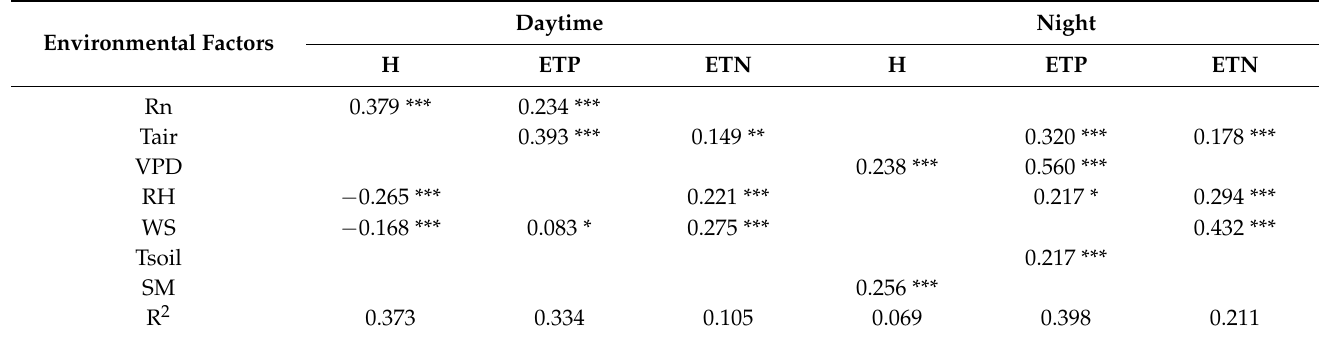
Table 1. Environmental driving forces of FEs under circadian alternation. The values in the table represent the regression coefficients between independent variables and dependent variables in the stepwise regression